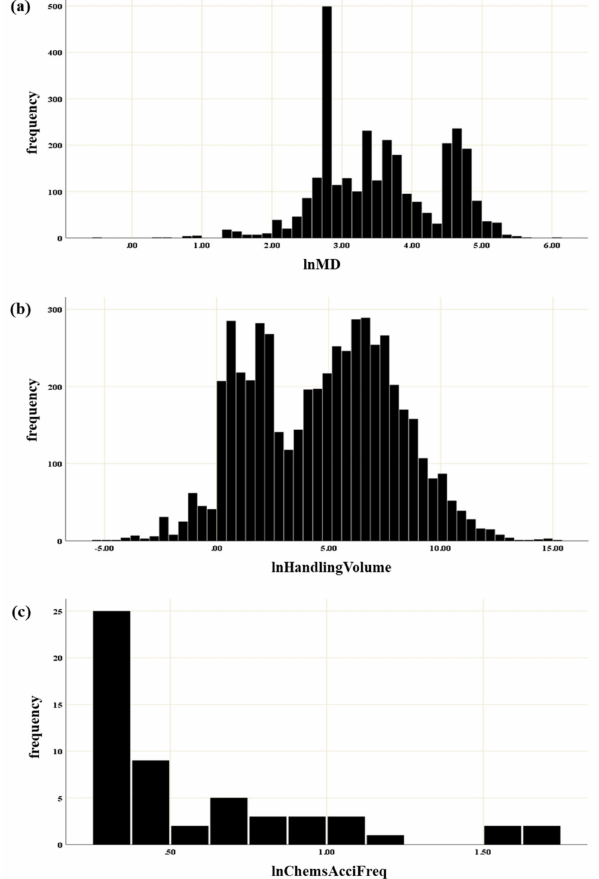
Figure 3. Distribution of the three surrogate indicators: ( a ) Mahalanobis distance of chemicals, ( b ) handling volume of chemicals, and ( c ) national accident frequency of